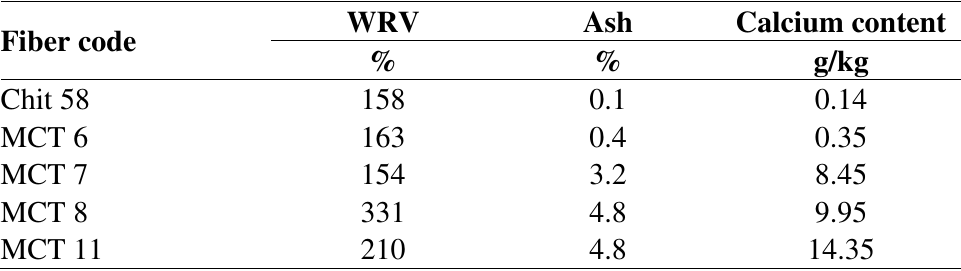
Table 4. Water retention value (WRV) content of calcium and ash in HAp/ β -TCP modified chitosan